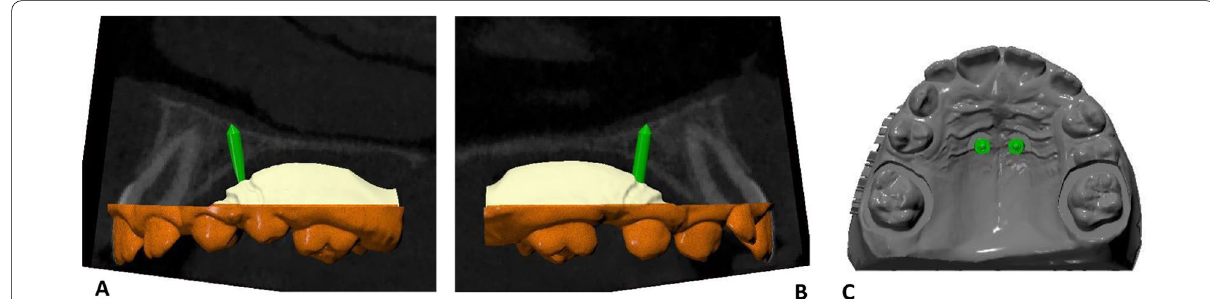
Fig. 1 Digital planning of bicortical insertion of two paramedian miniscrews using the REPLICA System ® . A , B virtual miniscrews position on the superimposition of cone-beam computed tomography and digital impression. C coronal view of the position of the virtual miniscrews on the digital